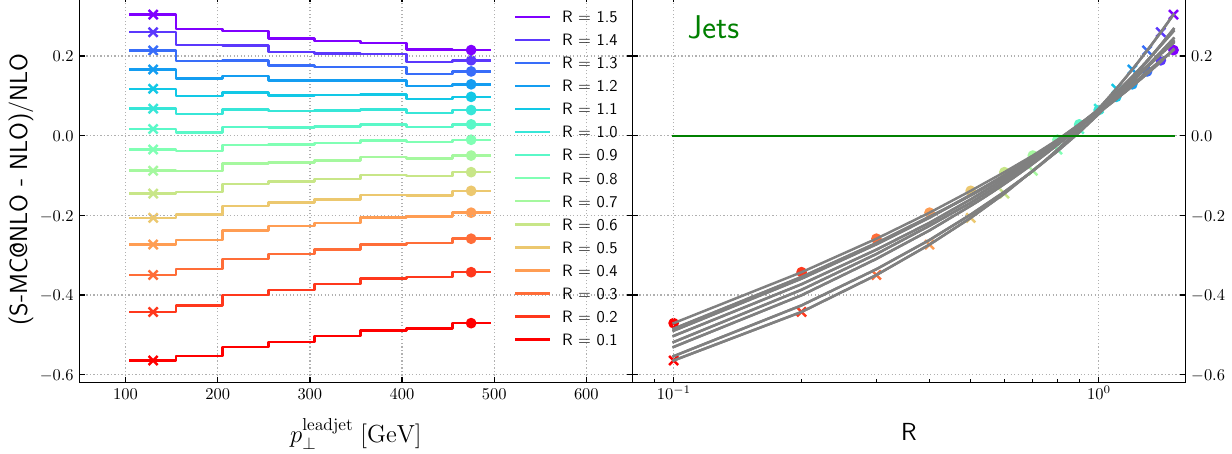
order corrections are minimized. Here we choose R 0 = 0 .